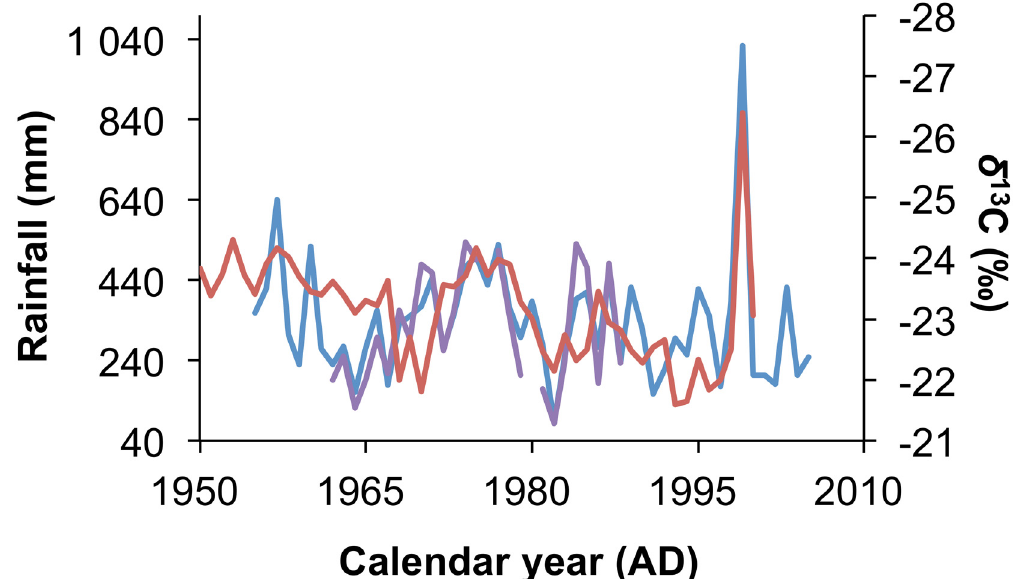
Fig 4. Rainfall calibration of the Mapungubwe baobab δ 13 C record. Instrumental rainfall records from Beitbridge provided by the Zimbabwe Weather Service (blue, left axis) and the South African Weather Service (purple, left axis) are significantly correlated with the δ 13 C record from the Mapungubwe baobabs (red, right axis).